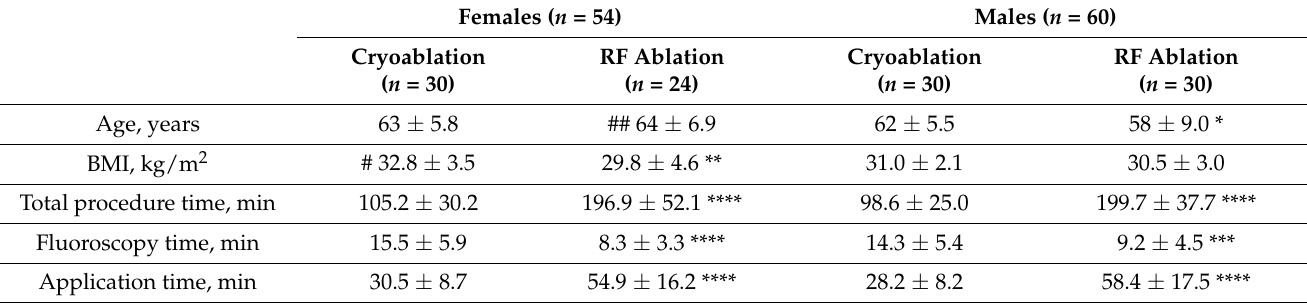
Table 2. Procedural characteristics and the type of ERAF after catheter ablation in obese females and obese